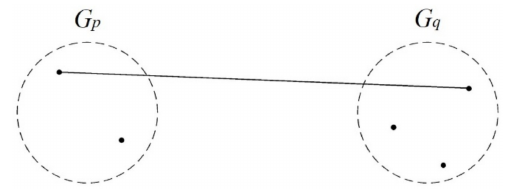
Figure 2. Conceptual diagram of the complete